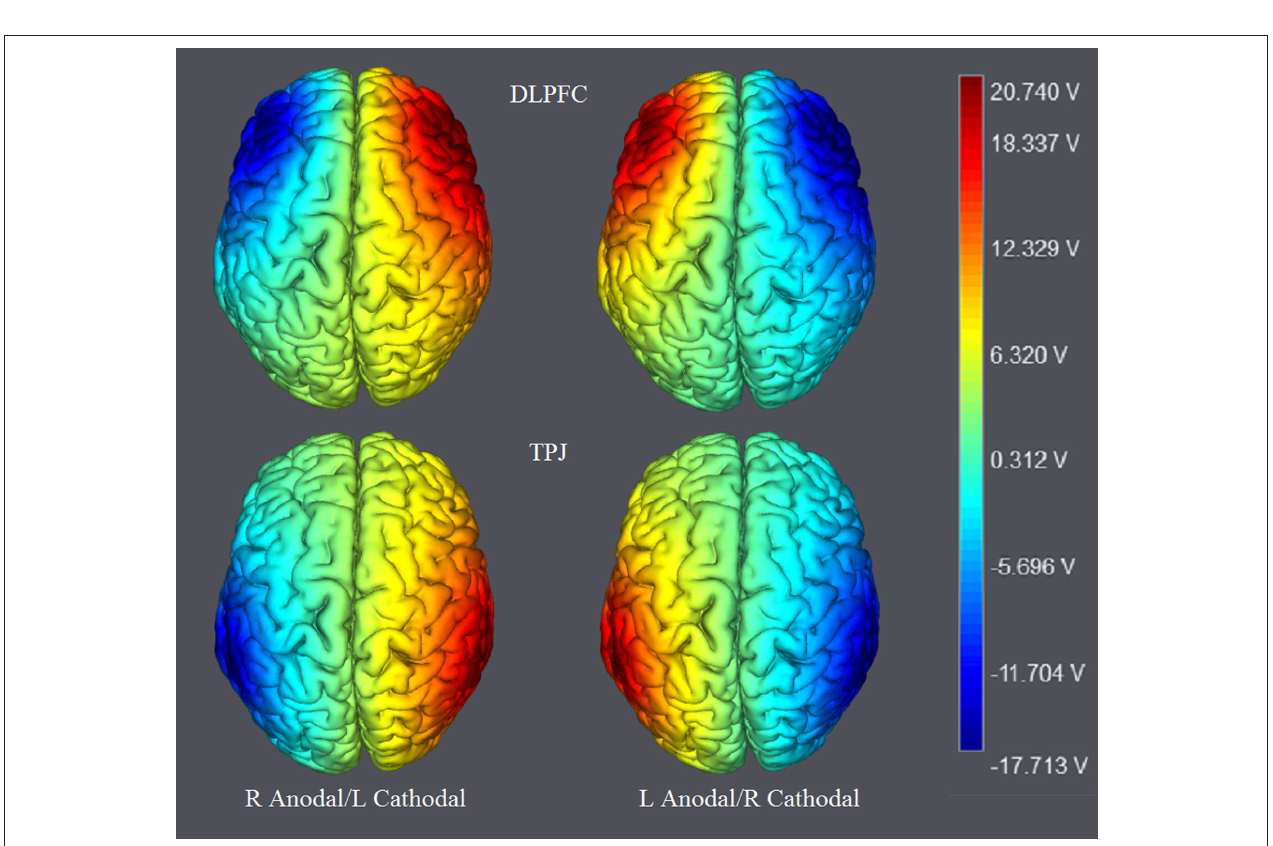
FIGURE 2 | The stimulation modes of tDCS treatments. The axis represents the range of input voltage from − 17.713 to 20.740V.